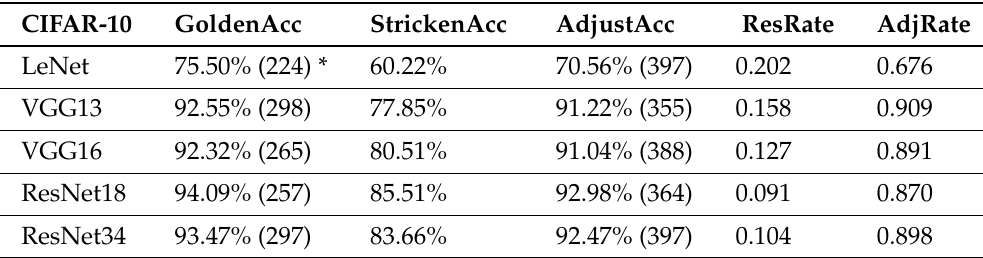
Table 4. CIFAR-10 with various